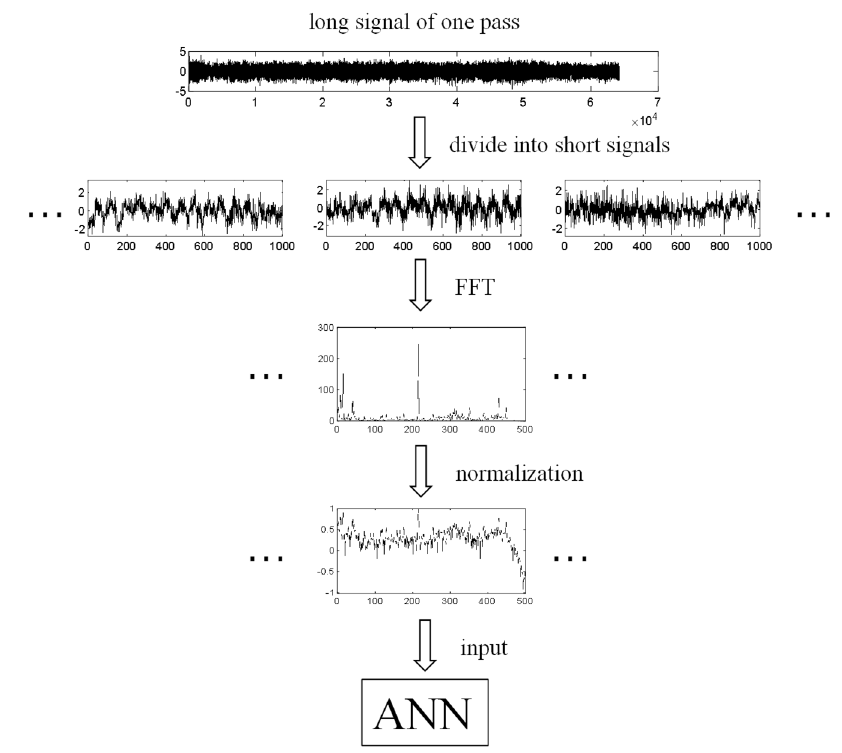
Figure 6. Signal processing. Table 2. Target class and compaction level.